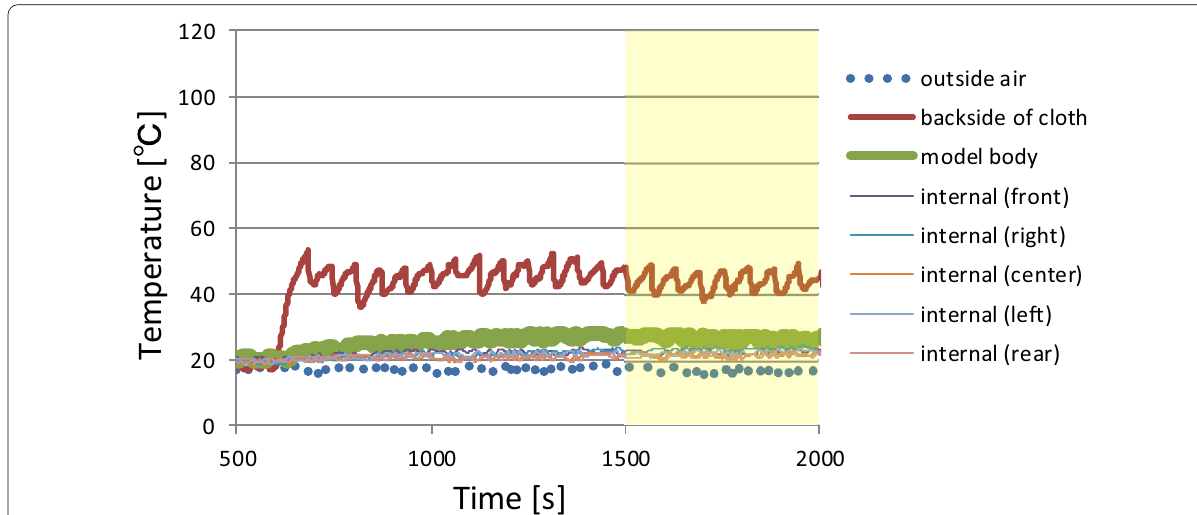
Fig. 13 Temperature measurement results by thermocouples. (e6) (OD-1/60)